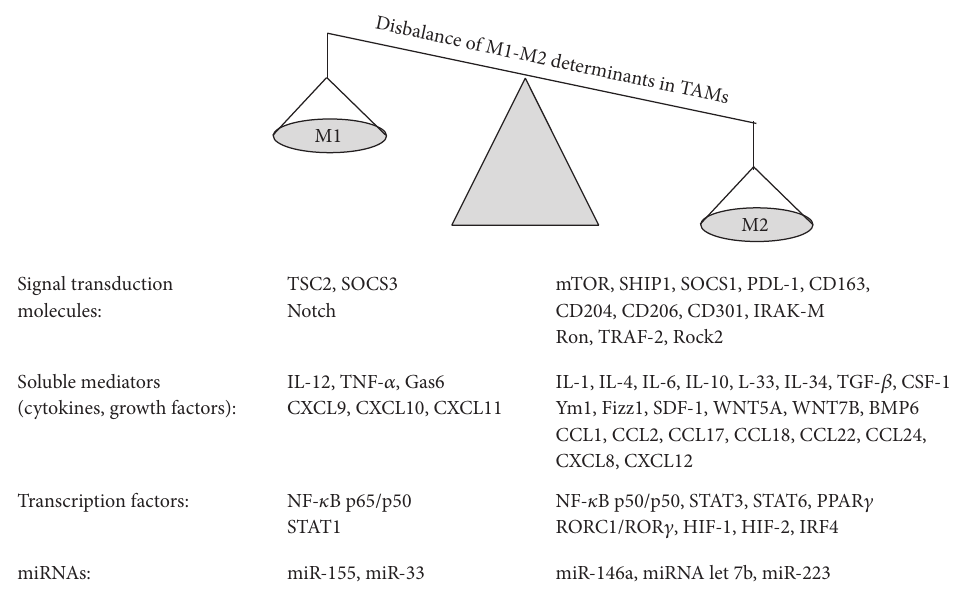
Figure 2: The polarization of TAMs is skewed to alternative activation due to p50/p50 nuclear accumulation, STAT3/STAT6 phosphorylation, and RORC1 transcription factor activation. M1 polarization promotes the expression of proinflammatory cytokines (IL-12, TNF- 𝛼 ) and chemokines (CXCL9, CXCL10, and CXCL11) whereas TAMs show anti-inflammatory phenotype (IL10, TGF- 𝛽 ) and the expression of CCL2, CCL17, CCL18, CCL22, and CCL24. M1-like (miRNA155, miR-33) and M2-like (miRNA146a, miRNA let 7b, and miR-223) miRNA profile are also a characteristic of macrophage polarization. See detailed explanation in the relevant section of the